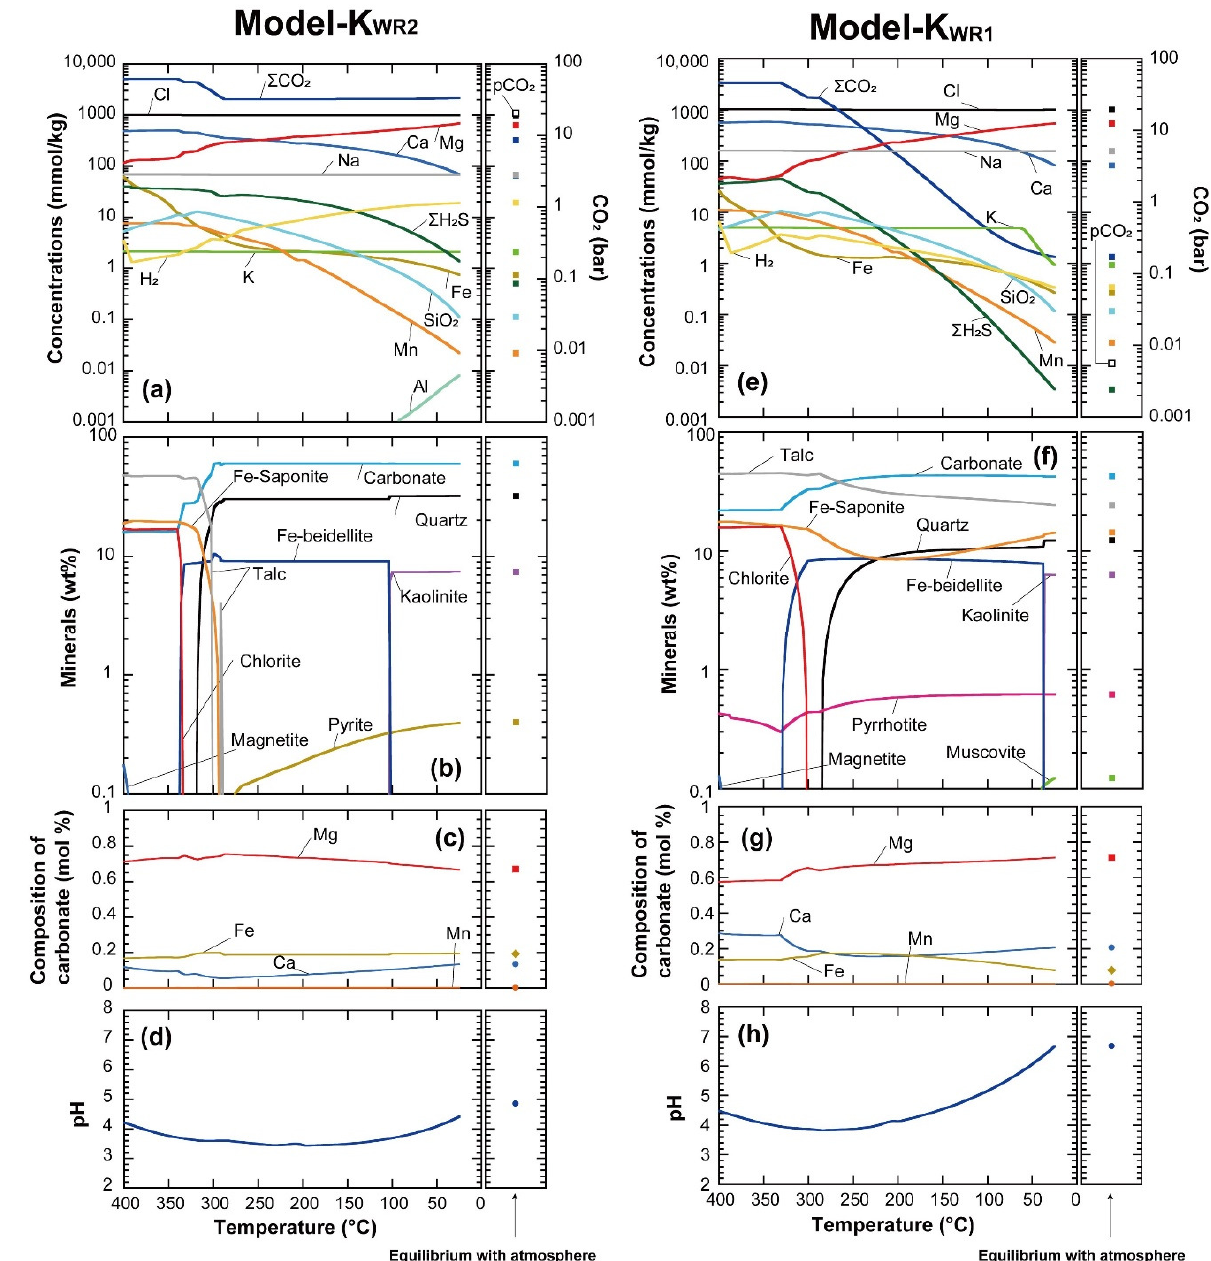
Figure 6. Predicted alteration, mineral abundance, and carbonate composition values for Model-K WR2 ( a – d ) and Model- K WR1 ( e – h ) as functions of temperature. In each panel, the results of the re-equilibration simulation for the gas phase, solution, and rock at 25 °C are shown on the right.